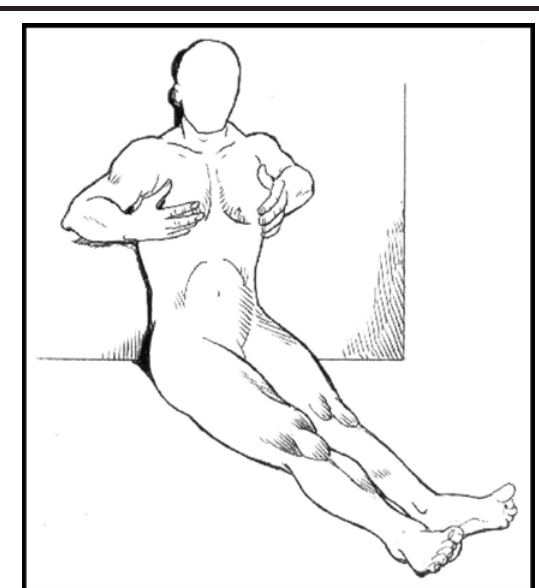
FIGURE 3 - Schematic drawing showing the individual seated with the hands supported on the thorax